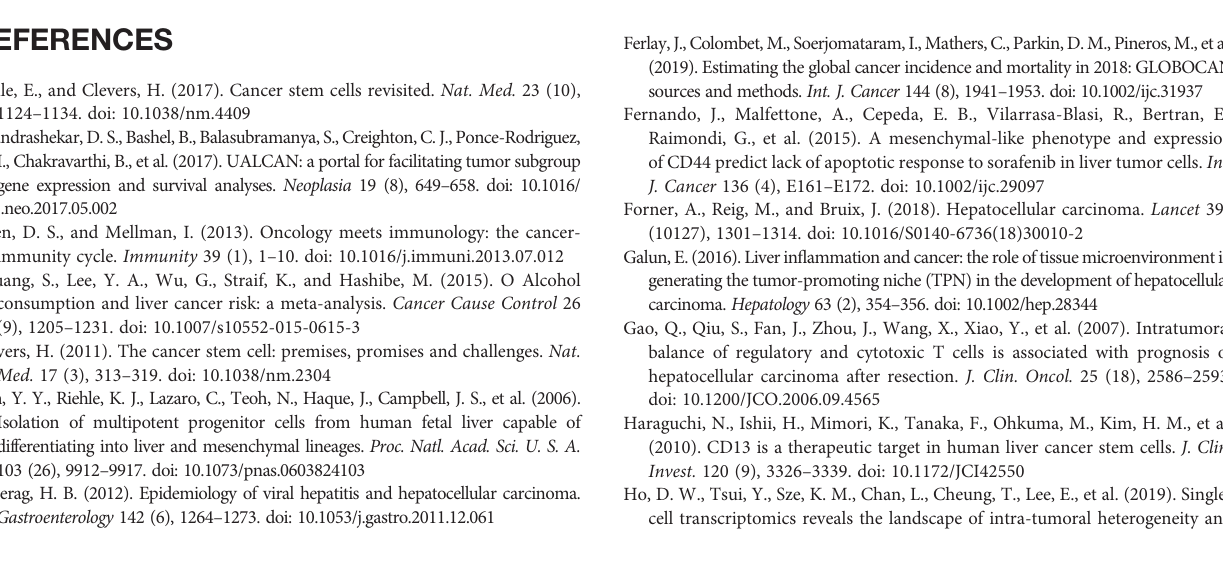
SUPPLEMENTARY FIGURE 2 | (A) HCSC markers expression levels at tumor major stages in HCC in GEPIA. (B) Expression of CD24 in LIHC based on individual cancer stages. P value (Normal V.S Stage1) = 4.61E-12, P value (Normal V.S Stage2) = 6.32E-08, P value (Normal V.S Stage3) = 3.87E-09, P value (Stage1 V.S Stage3) = 0.0015. Expression of SOX12 in LIHC based on individual cancer stages. P value (Normal V.S Stage1) = 1.62E-12, P value (Normal V.S Stage2) = 3.99E-11, P value (Normal V.S Stage3) = 1.28E-09, P value (Normal V.S Stage4) = 0.0061, P value (Stage1 V.S Stage2) = 0.0427, P value (Stage1 V.S Stage3) = 0.0028. (C) Expression of CD24 in LIHC based on nodal metastasis status. P value (Normal V.S N0) = <1E-12, P value (Normal V.S N1) = 0.0064, P value (N0 V.S N1) = 0.0121. Expression of SOX12 in LIHC based on nodal metastasis status. P value (Normal V.S N0) = 1.62E-12, P value (Normal V.S N1) = 0.0433, P value (N0 V.S N1) = 0.0121. N0, no regional lymph node metastasis. N1, metastases in 1 to 3 axillary lymph nodes. TPM, Transcript per million. SUPPLEMENTARY FIGURE 3 | Association of 14 HCSC markers expression levels and prognosis of HCC. (A) Correlation of HCSC markers high expression levels with OS of HCC, n=364, (B) correlation of HCSC markers high expression levels with PFS of HCC, n=370, red font means negative correlation, green font means positive correlation, black font means no correlation. SUPPLEMENTARY FIGURE 4 | Association of HCSC markers expression levels and prognosis of HCC in stage I and II. (A) Correlation of HCSC markers high expression levels with OS of HCC in stage I and II, n=253, (B) correlation of HCSC markers high expression levels with PFS of HCC in stage I and II, n=256, red font means negative correlation, green font means positive correlation,black font means no correlation. SUPPLEMENTARY FIGURE 5 | Association of HCSC markers expression levels and prognosis of HCC in stage III and IV. (A) Correlation of HCSC markers high expression levels with OS of HCC in stage III and IV, n=87, (B) correlation of HCSC markers high expression levels with PFS of HCC in stage III and IV, n=90, red font means negative correlation, green font means positive correlation,black font means no correlation. SUPPLEMENTARY FIGURE 6 | Association of HCSC markers expression levels with prognosis of HCC with different gender. (A) Correlation of HCSC markers high expression levels with OS (n=246) and PFS (n=246) of male patient with HCC, (B) correlation of HCSC markers high expression levels with OS (n=118) and PFS (n=120) offemale patient with HCC, red font means negative correlation, black font means no correlation. (C) Expression of HCSC markers in LIHC based on patient's gender. The median TPM and P value list in Table 2 . SUPPLEMENTARY FIGURE 7 | KEGG enrichment plot of KEGG pathway by functional annotation